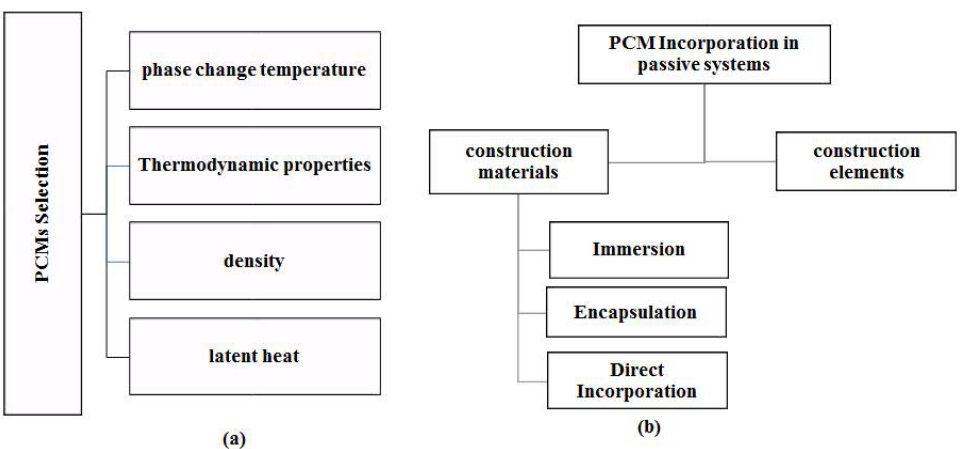
Figure 3. Researches in PCM process: ( a ) study in materials properties, ( b ) Methods of integrating of PCM into building envelopes. Adopted from [18].